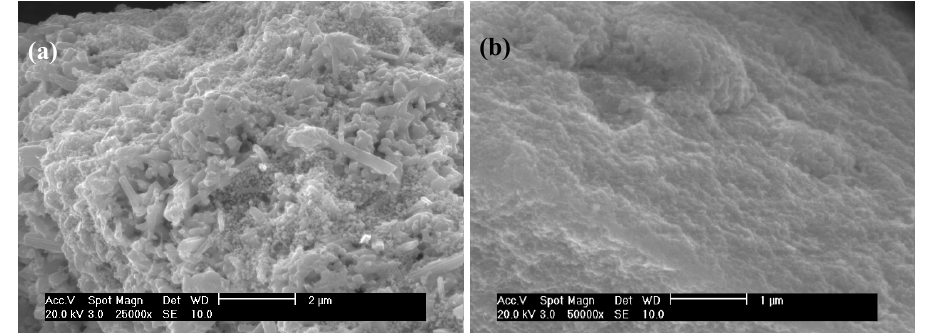
Figure 13. SEM images for samples collected from the hot zone of experiment B3, revealing the existence of a small amount of nanotubes ( a ), and the fine and uniform ( b ). IF-WS 2